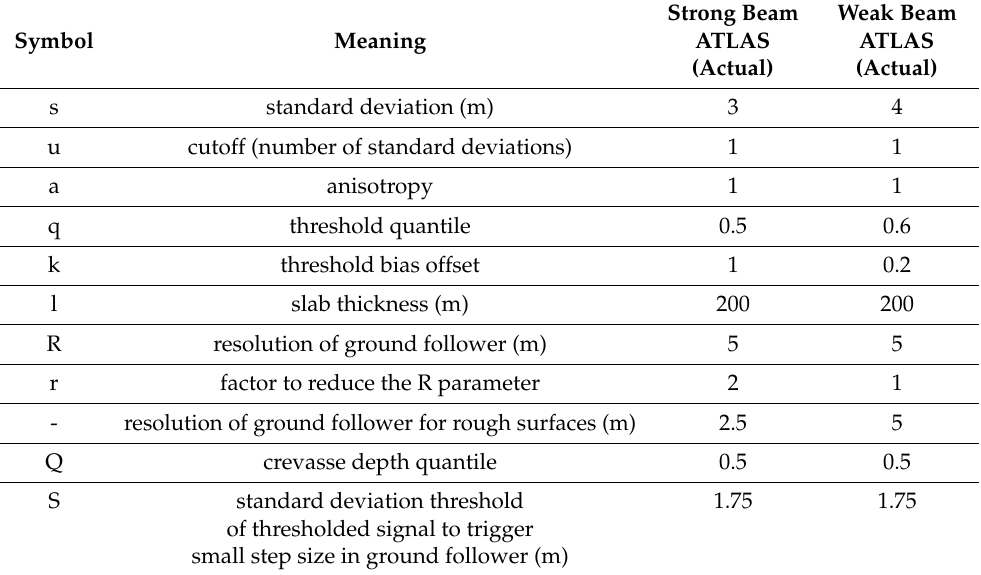
Table 2. DDA-ice parameters. Strong beam, weak beam—ATLAS beams. Parameters are the same as used in [3], parameters used for strong beam are the same as parameters optimized for analysis of SIMPL_green (532nm parallel polarized) channels. Variables Q and S are now algorithm-specific parameters for DDA-ice. Resolution of the ground follower is 2.5 m over rough/ crevassed surfaces and 5 m over smooth surfaces. See also [21]. Strong Beam Symbol Meaning